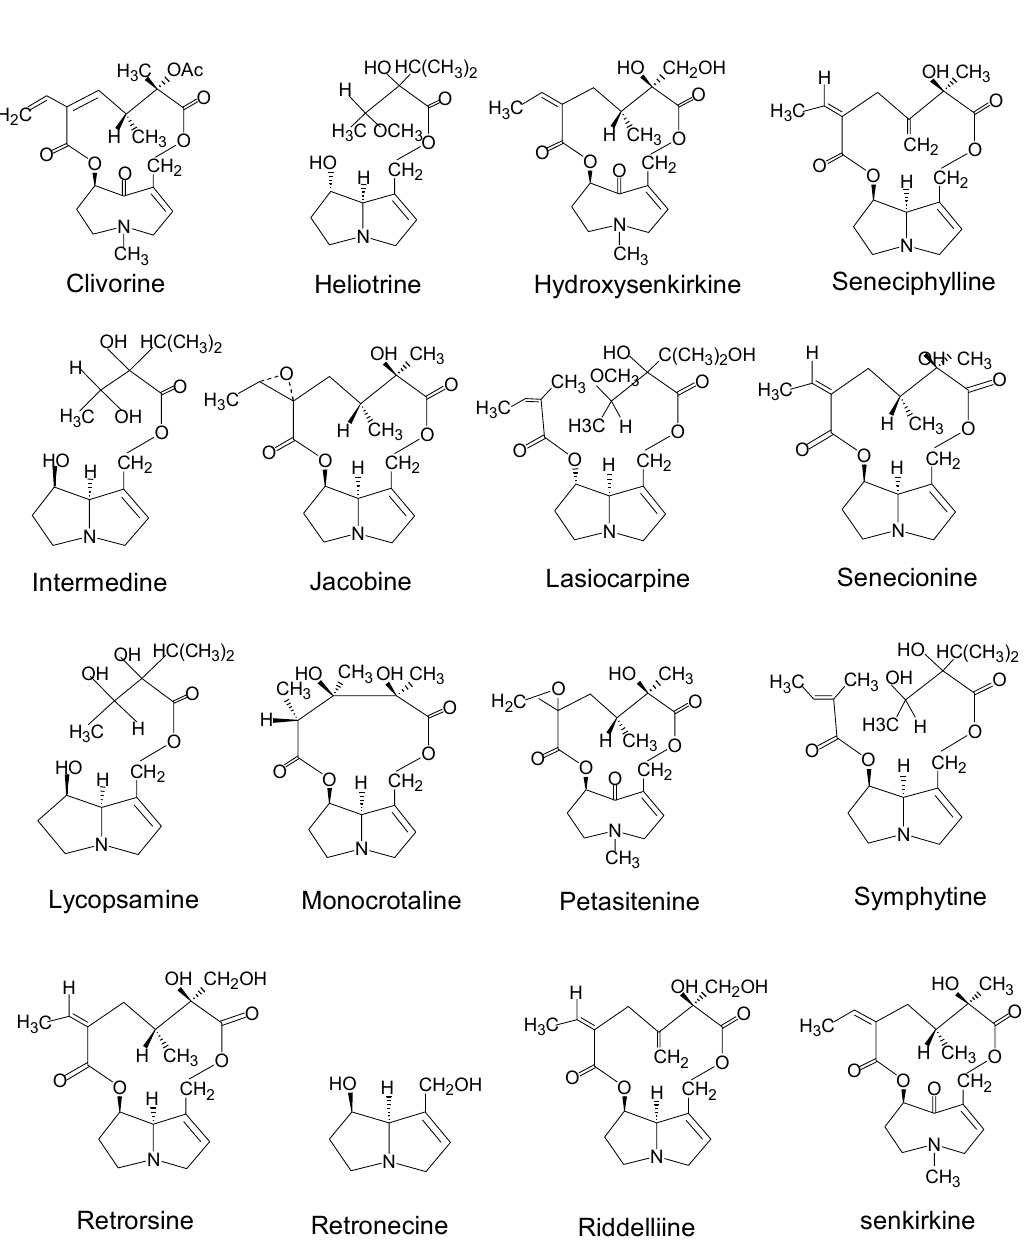
Figure 4. Names and structures of tumorigenic pyrrolizidine